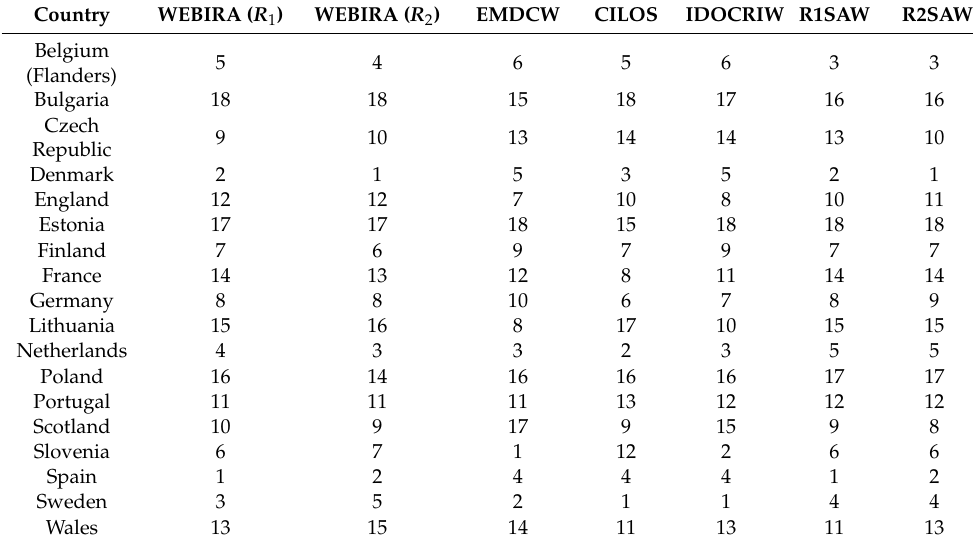
Table 9. Ranks of European countries obtained by both weight balancing indicator ranks accordance (WEBIRA), entropy method for determining the criterion weight (EMDCW), method of criteria impact LOSs and determination of objective weights (CILOS), integrated determination of objective criteria weights (IDOCRIW), R1SAW and R2SAW methods.